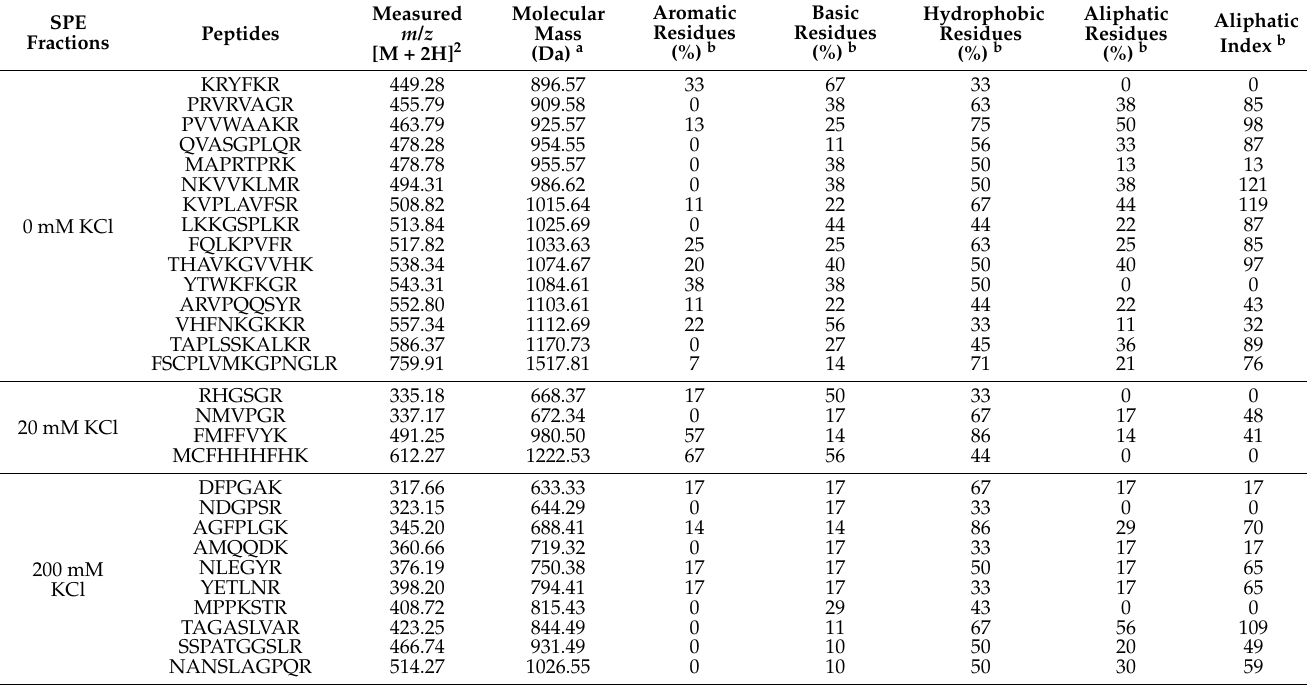
Table 1. Physicochemical properties of the peptides identified from the 0, 20, and 200 mM KCl fractions. SPE Fractions